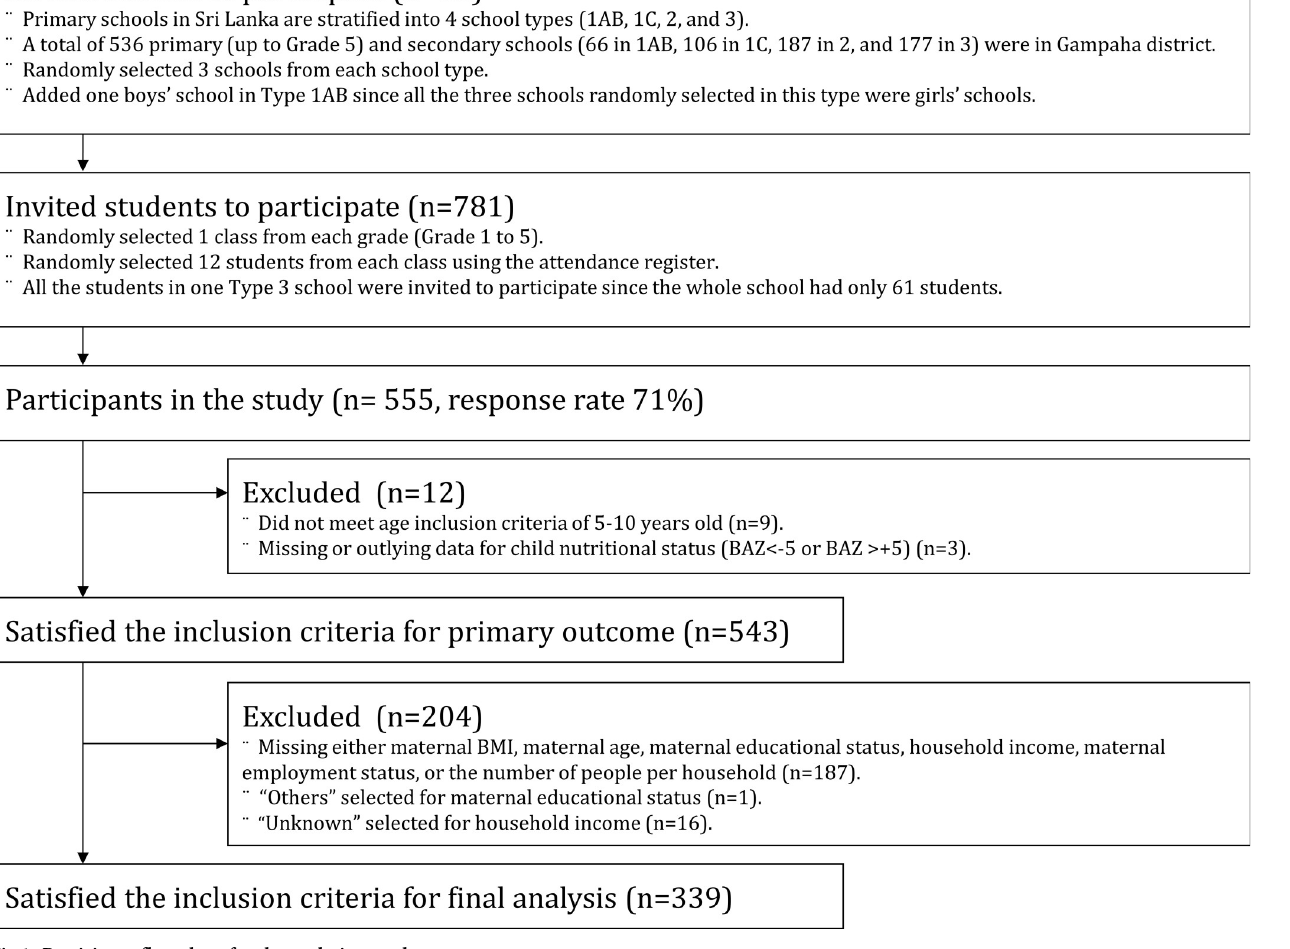
Fig 1. Participant flow chart for the analytic